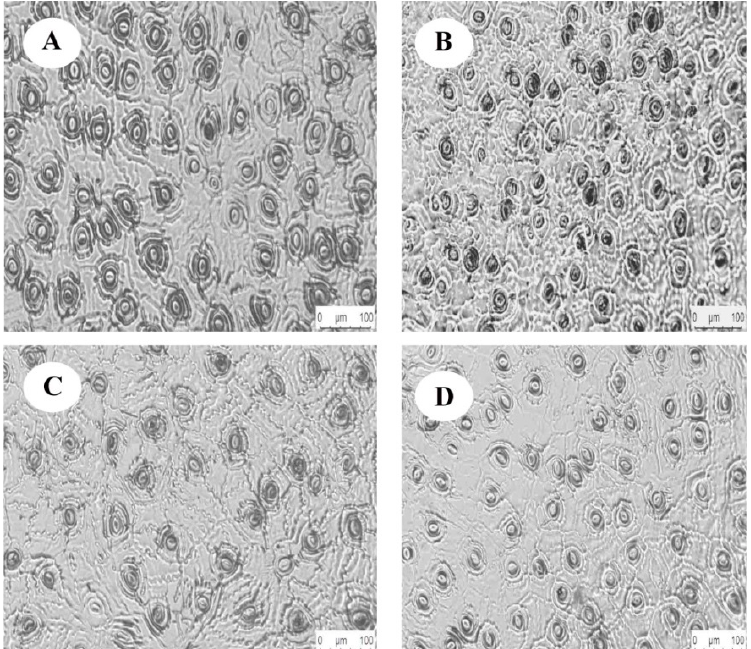
Figure 3. Stomatal structure of C. oleifera leaves under different light regimes. Note: CK: 100% light regime ( A ); HL: 75% light regime ( B ); ML: 50% light regime ( C ); LL: 30% light regime ( D ).